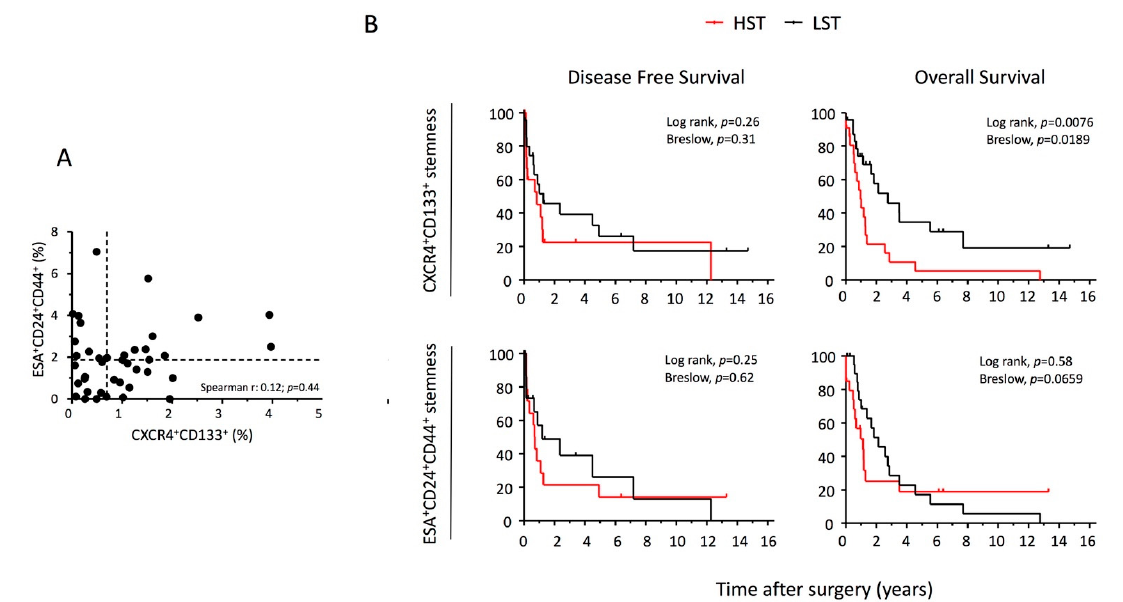
Figure 5. PDAC tissue stemness phenotype and overall/disease-free survival. Tumor tissues from 47 patients were enzymatically and mechanically processed in order to isolate single cells for FACS analysis. ( A ) Correlation between ESA + CD24 + CD44 + and CXCR4 + CD133 + cell percentage. Spear- man ’ s rho statistic was applied. Dotted lines represent the median values. ( B ) Kaplan–Meier curves representing the overall survival and disease-free survival. Tumors were divided in two groups according to median of ESA + CD24 + CD44 + or CXCR4 + CD133 + cell percentage [high stemness tumor (HST) > median, low stemness tumor (LST) ≤ median]. Statistical analysis was performed by log- rank test and Breslow test.